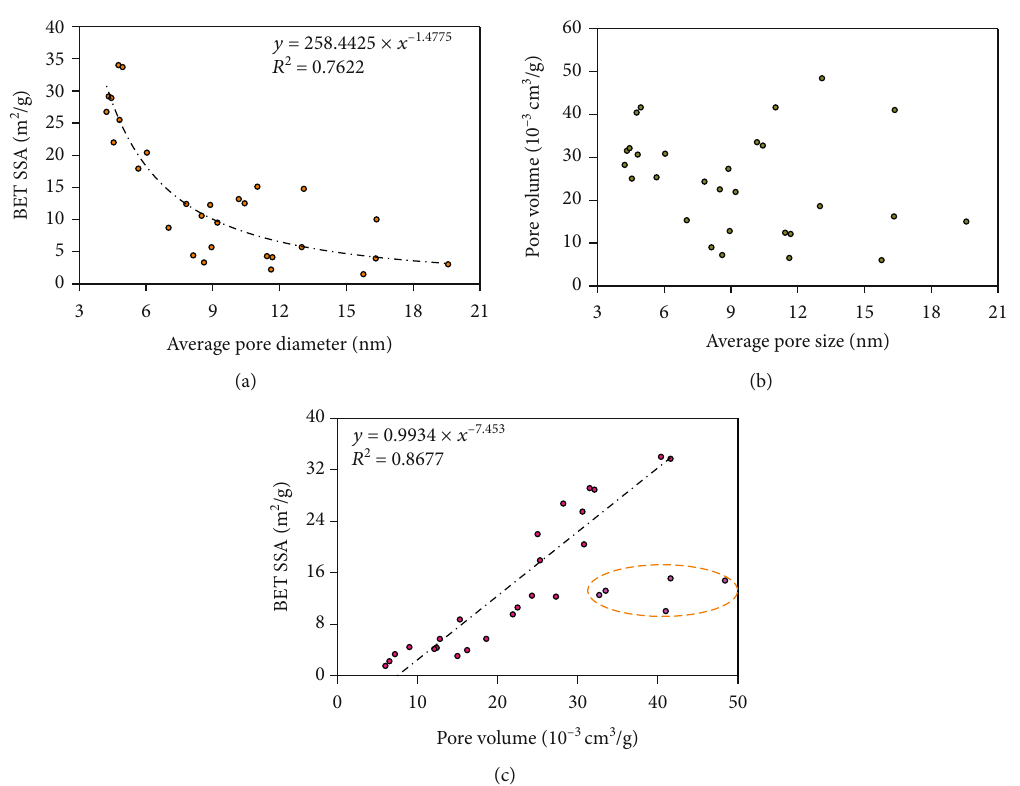
Figure 6: Relationship among various pore structure